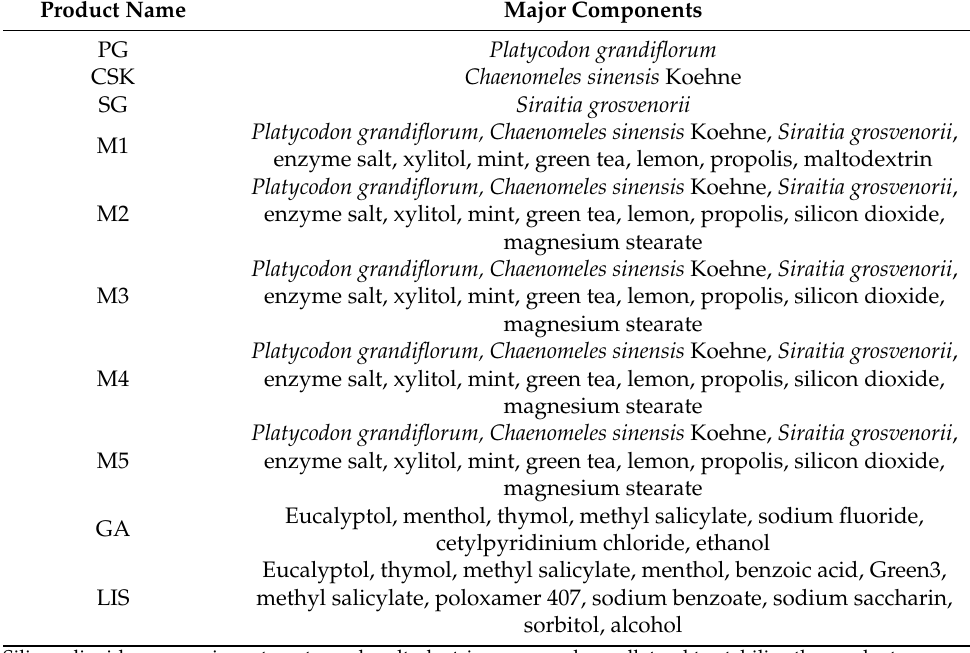
Table 2. Major components of the materials.